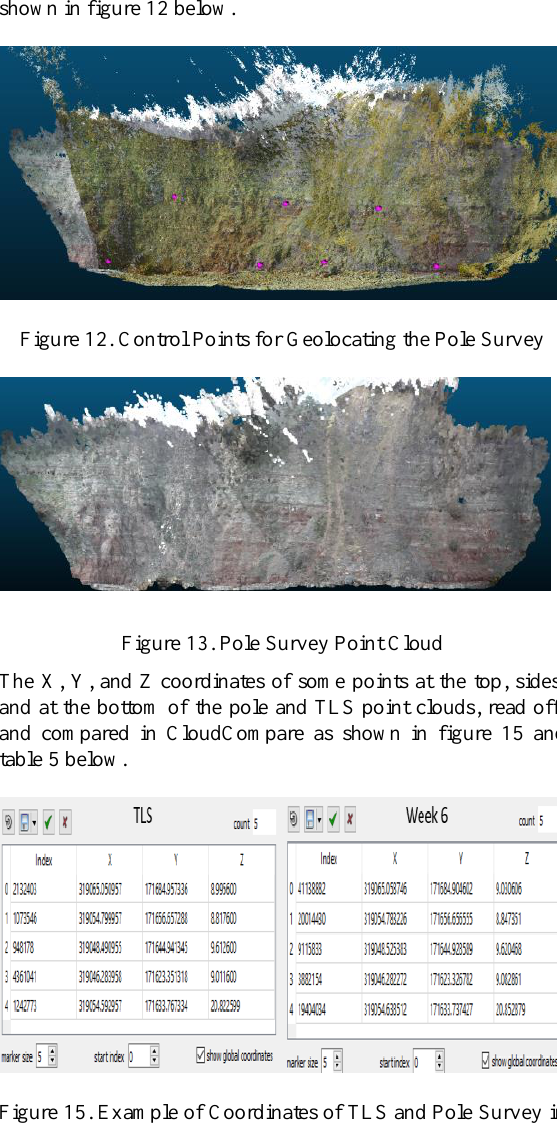
Figure 15. Example of Coordinates of TLS and Pole Survey in CloudCompare Table 5. Differences in the Coordinates of some Points